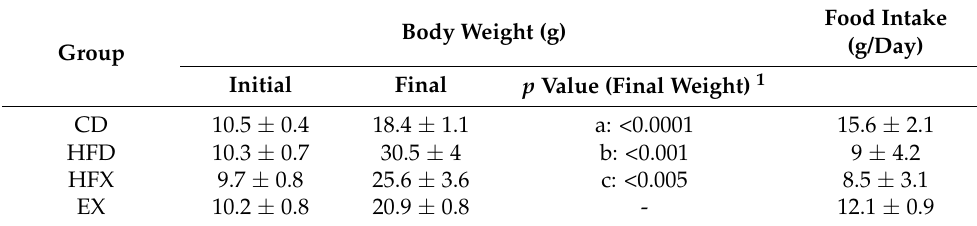
Table 1. Body weight and food intake of mice.